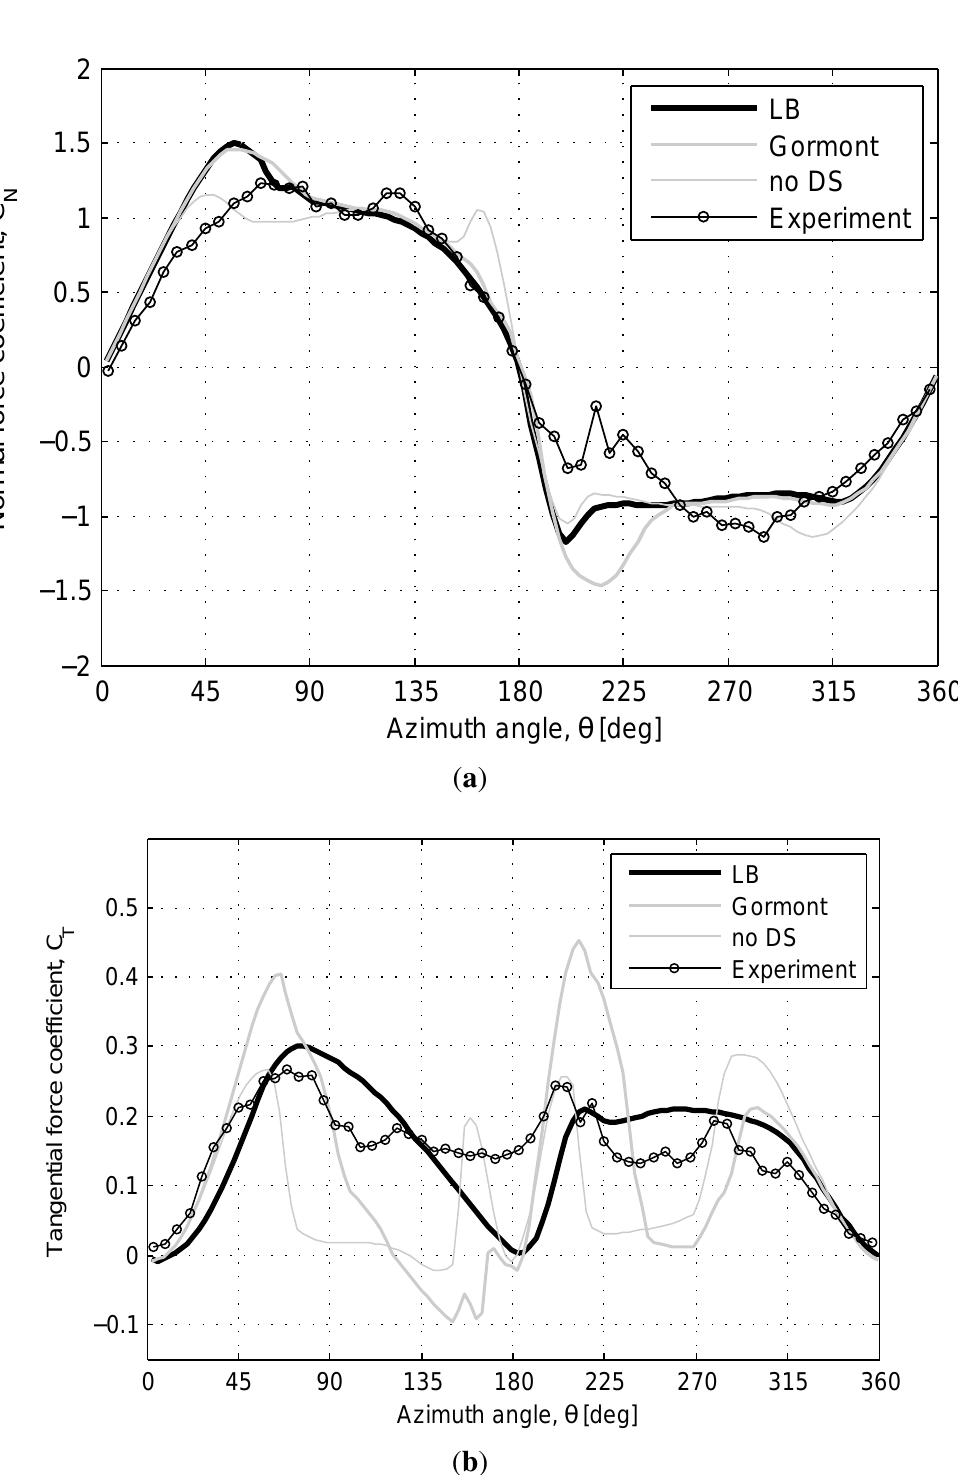
Figure 8. Force response at a TSR of 2.33. ( a ) Normal force; ( b ) tangential